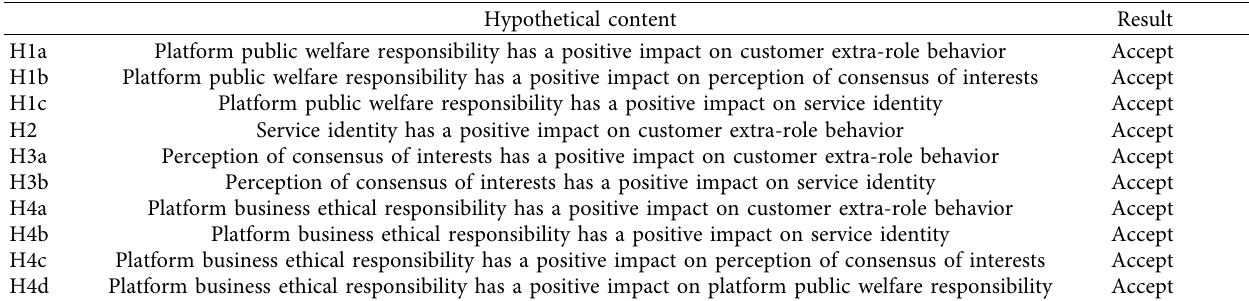
Table 9: Hypothesis test